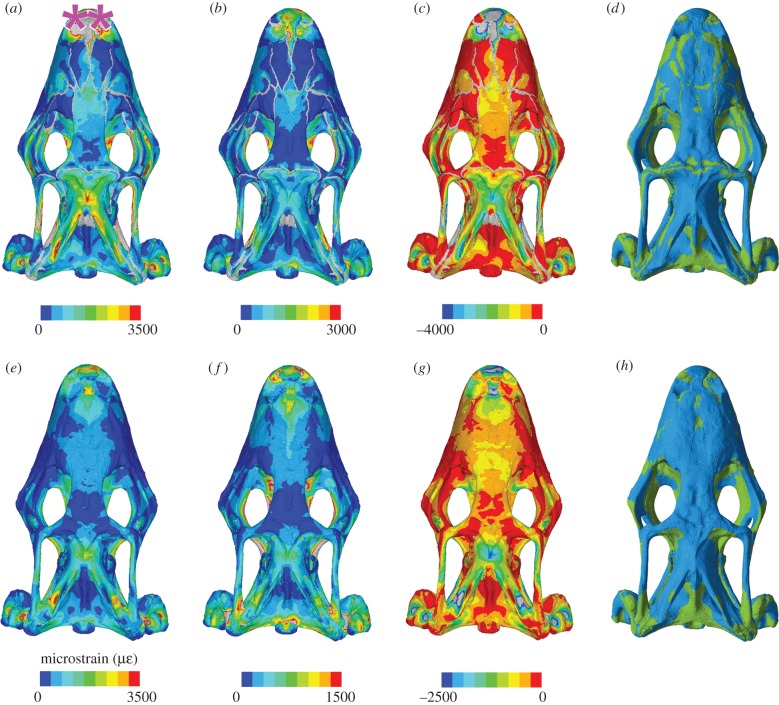
Strain contour plots and tension–compression dominance plots of the cranium under anterior loading in dorsal view with a chondrocranium of 200 MPa and sutures present (a–d) and absent (e–h) showing: von Mises strain (a,e), 1st principal strains (b,f), 3rd principal strains (c,g) and plots of whether strains are dominated by tension (green) or compression (blue). The pink asterisks indicate the location along the tooth row at which loading was applied (a–h). In the contour plots, strain values are given in microstrain and the sutures are shown in grey (a–c and e–g).